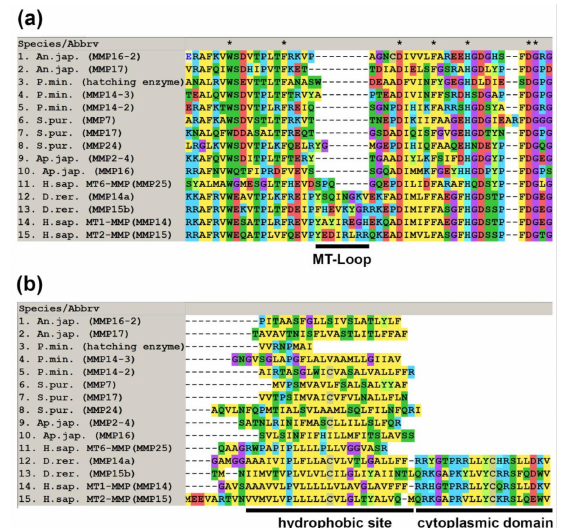
Figure 4. MUSCLE (MegaX) alignment of amino acid sequences of MMPs with a posterior transmem- brane domain of echinoderms and vertebrates. ( a ) Catalytic domain with MT-Loop; ( b ) C-terminus of